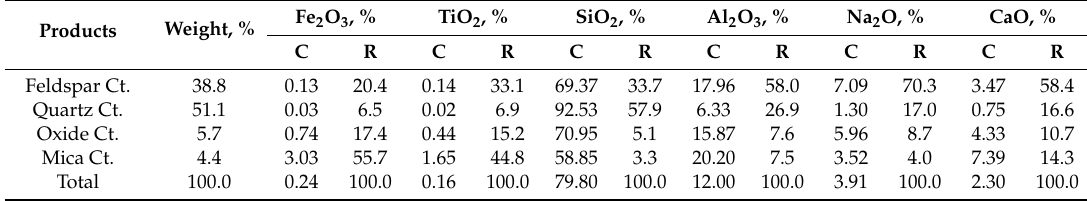
Table 5. The results of the flotation test using Duomeen TDO (without using hydrofluoric acid). Products Feldspar